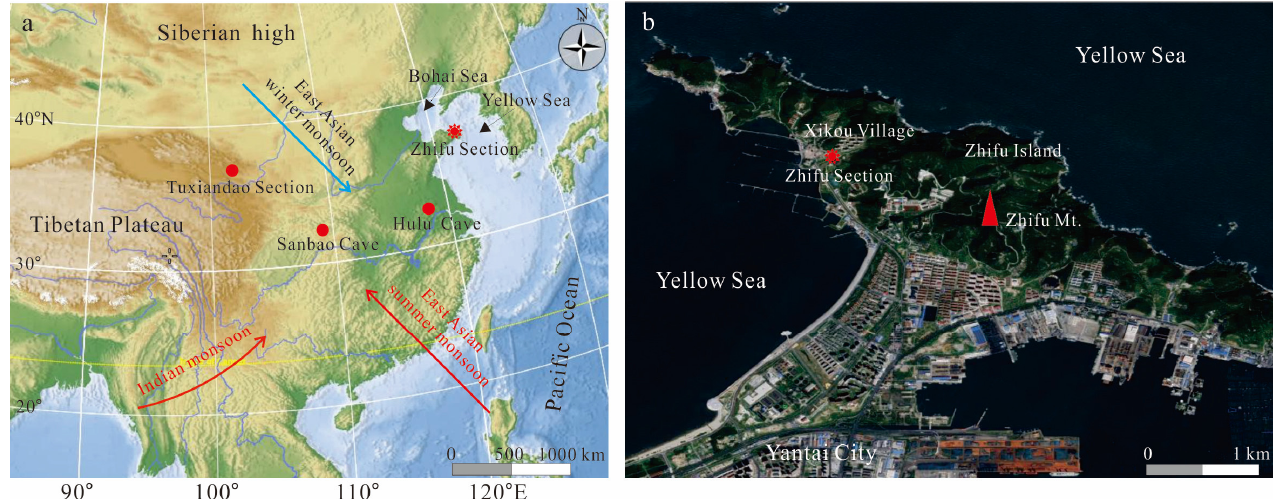
Figure 1. ( a ) Location of the study area in China and trajectories of the major wind systems. ( b ) Location of the Zhifu section within Shandong Province.